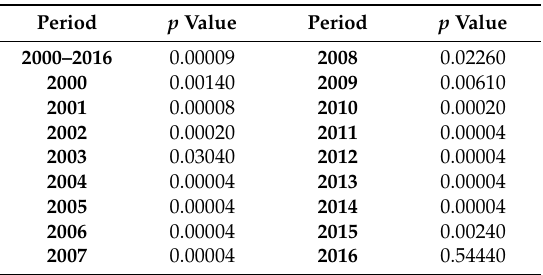
Table 4. Wilcoxon test results ( p